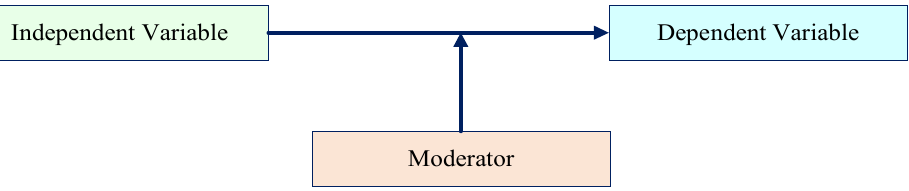
Figure 3. Moderation model adapted from Baron and Kenny (1986).